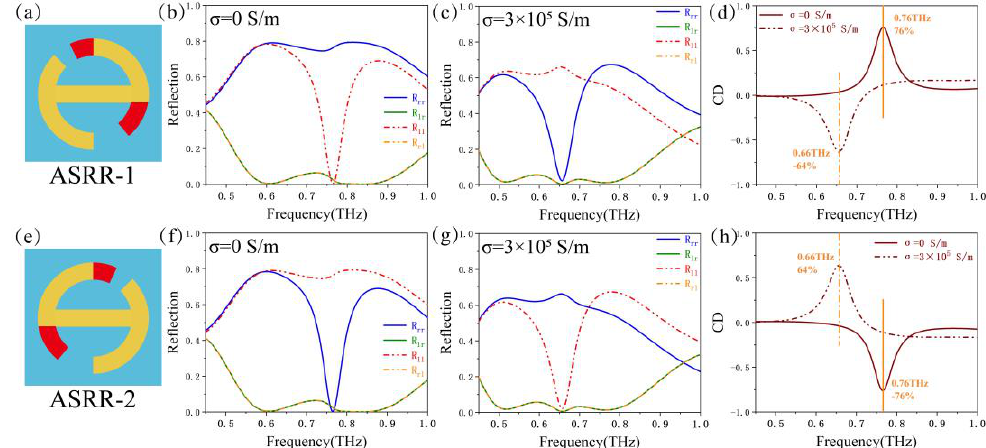
Figure 2. Schematic diagram of structural units, reflection spectrum and circular dichroism curve spectrum of ( a – d ) ASRR_1 and ( e – h ) ASRR_2.